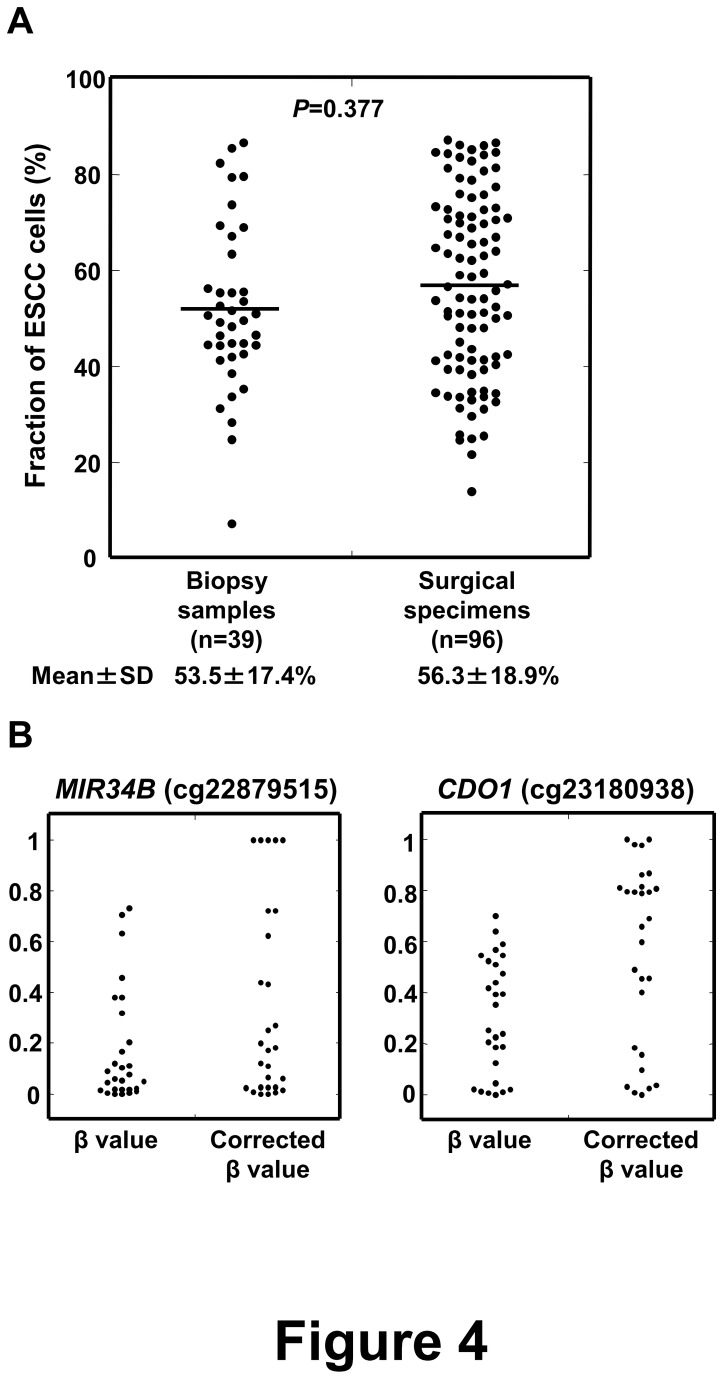
Application of the fraction marker.(A) Application of the fraction marker to comparison of the fraction of cancer cells between biopsy samples and surgical specimens. Fractions of cancer cells in 39 biopsy samples and 96 surgical specimens were estimated by the fraction marker, and no significant difference was observed. (B) Application of the fraction marker to DNA methylation analysis. Raw β values of two CpG sites [cg22879515 (MIR34B), cg23180938 (CDO1)] were corrected by the cancer cell content in 28 ESCCs. Some ESCCs had almost complete methylation (β value ≥ 0.8).